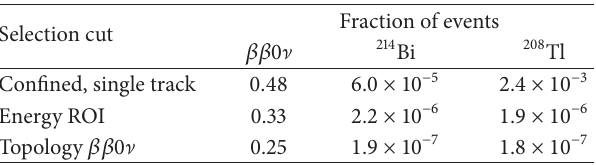
Table 4: Acceptance of the selection cuts for signal and back-